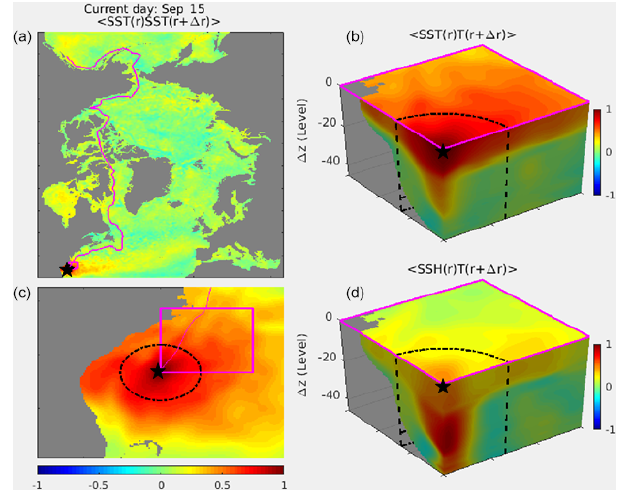
Figure 3. Example of spatial structures of multivariate correlations from background error modes for 15 September in the Gulf Stream region. The left panels show the spatial correlation of SST with the point marked with a star over the full domain (a) and over a magni- fied region (c) . The right panels show the spatial correlation of SST with 3D temperature (b) and the spatial correlation of SSH with 3D temperature (d) . The 3D cube is plotted such that the bottom left corner corresponds to the point marked with the star. The vertical dimension is plotted using the model level to enhance the resolu- tion near the surface. Levels 20 and 40 roughly correspond to 60 and 200m of depth, respectively. The spatial extent of the cube is shown in the left panel as a magenta box. The bubble radius used in the Gaussian localization function to reduce long-range spurious covariances is shown as a dashed oval. Model bathymetry is shown in grey. An animated version of this figure is available for which the central point marked with a star moves along the magenta line (see the